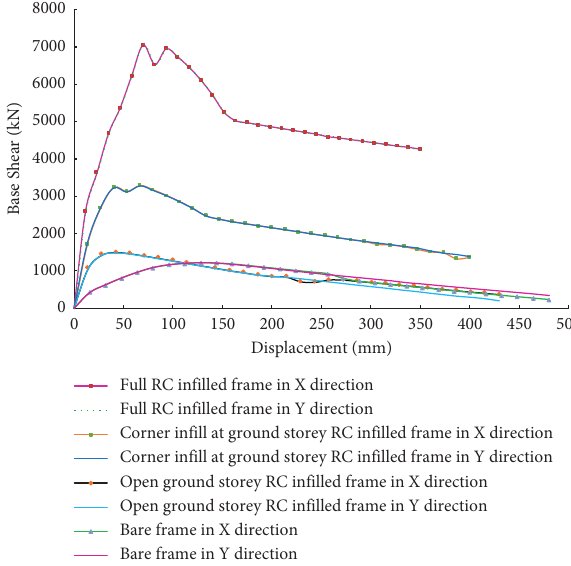
Figure 7: Comparison of pushover curves from all structural